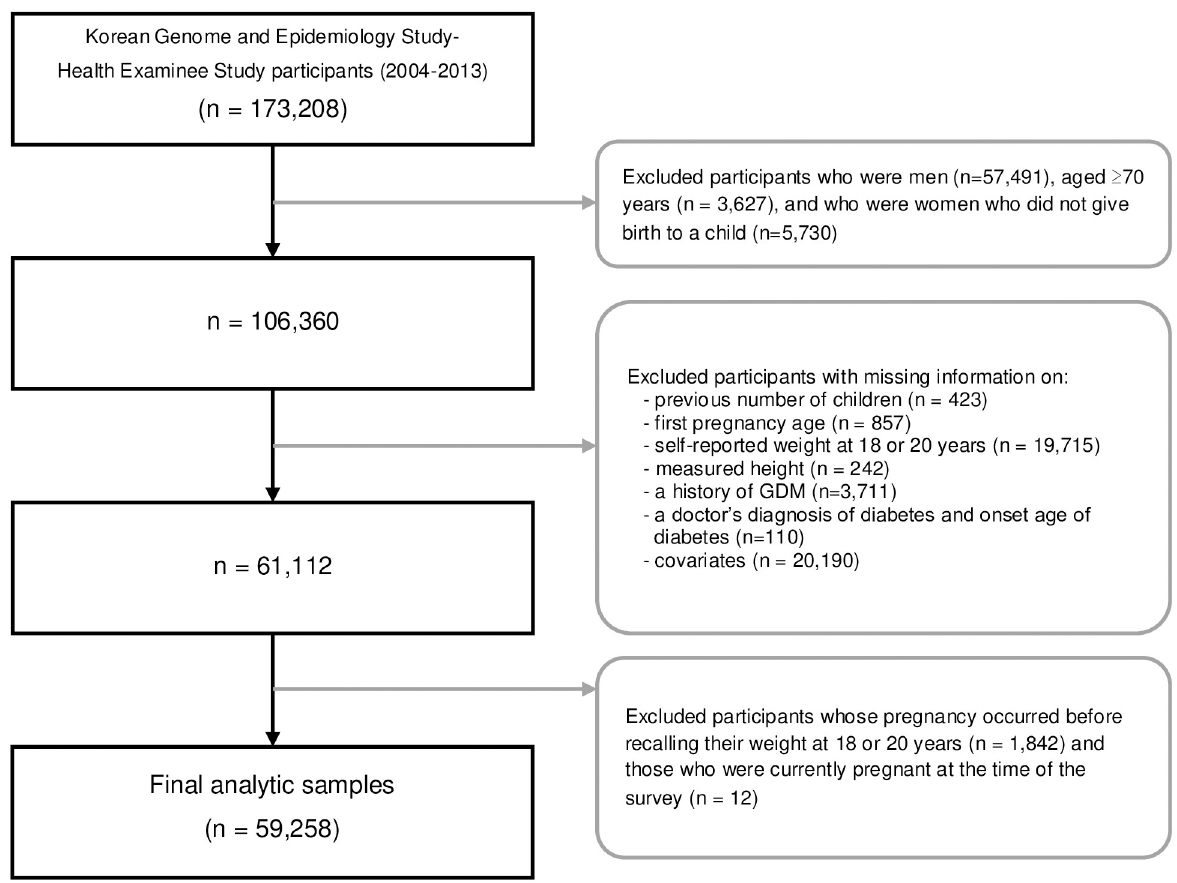
Fig 1. Flow chart of study